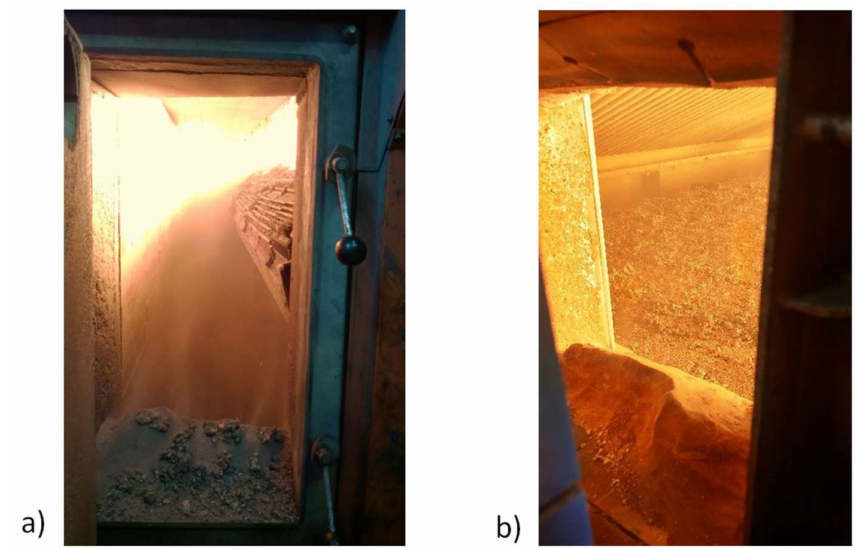
Figure 5. The end section of the grate with discharge of the slag to the slag trap—view from the back inspection door of the boiler: ( a ) operation with full load, ( b ) operation with 30% of load during off-season period.